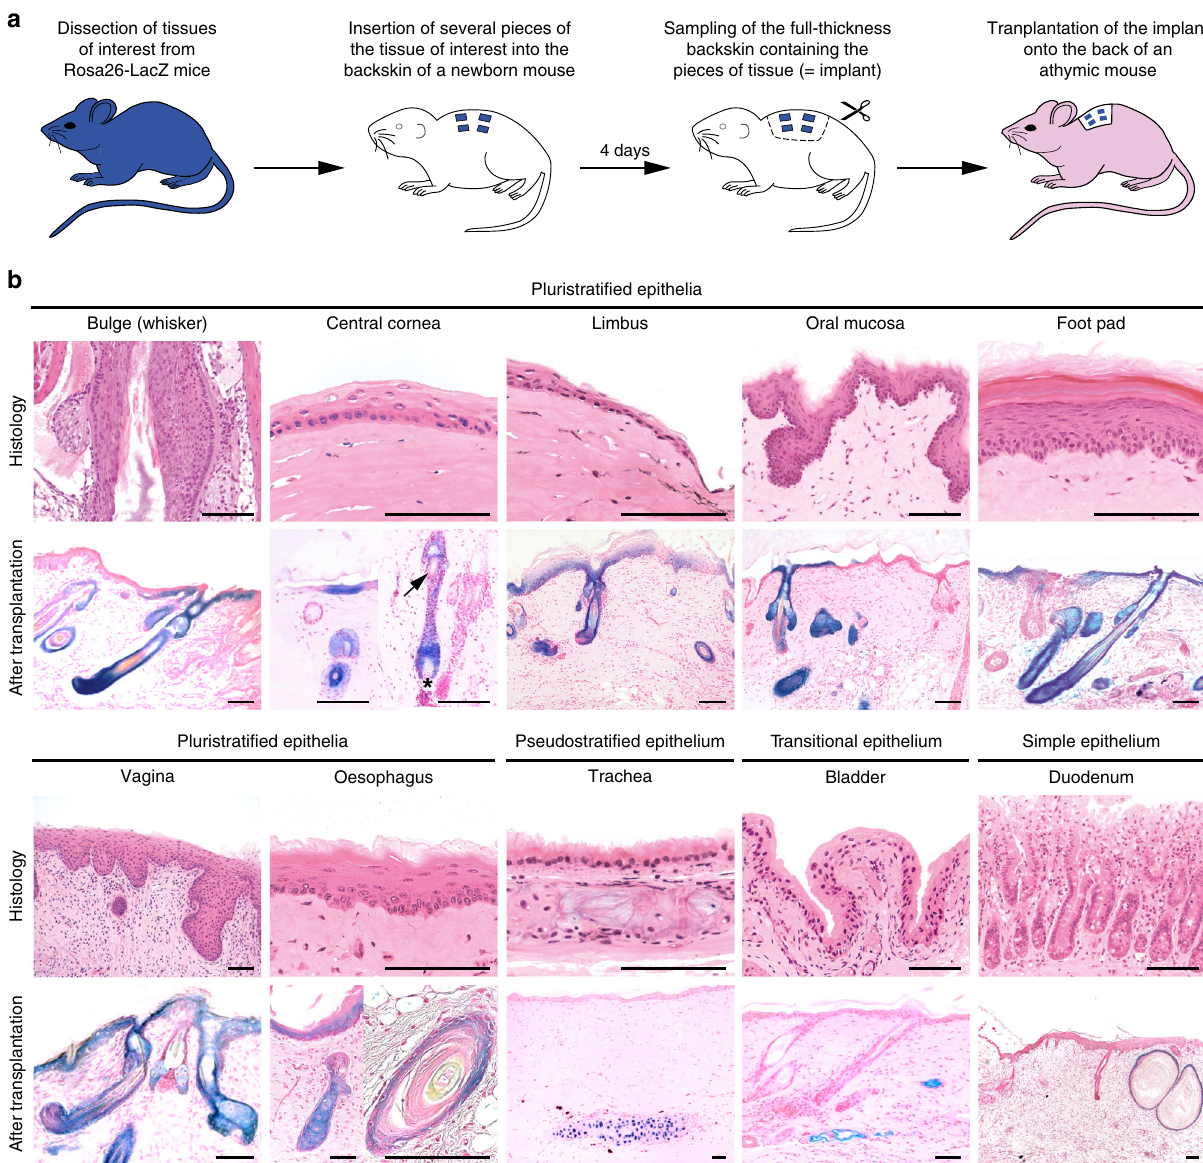
Fig. 4 Stem cells from squamous epithelia have innate skin competence. a Schematic representation of an experiment to determine the hair-forming ability of a non-hairy epithelial tissue. A total of 204 mice were transplanted with various β -galactosidase-expressing epithelial tissues. For each tissue, the number of transplanted mice and the number of positive transplants are given in Supplementary Table 6. b Microscopic appearance of the different tissues before transplantation and after transplantation into a newborn wild type mouse skin microenvironment. Donor tissue expressing β -galactosidase: blue; X-gal staining; recipient newborn mouse tissue: pink; Nuclear Fast Red. The arrow points to a club hair in a hair follicle generated from cornea; the presence of a club hair indicates that the hair follicle has cycled. The star shows a pink follicular papilla, hence indicating that it has originated from the mesenchyme of the recipient mouse skin. Bars: 100 μ